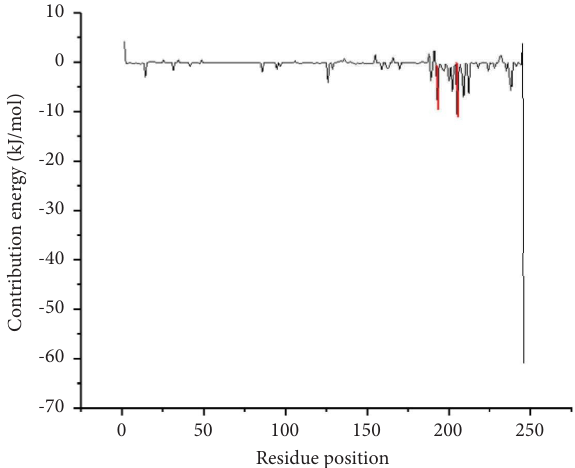
Figure 10: Per-residue energy decomposition trajectory showing the energy contributions of the various amino acid residues to- wards the stability of the 5 α R-2-A1